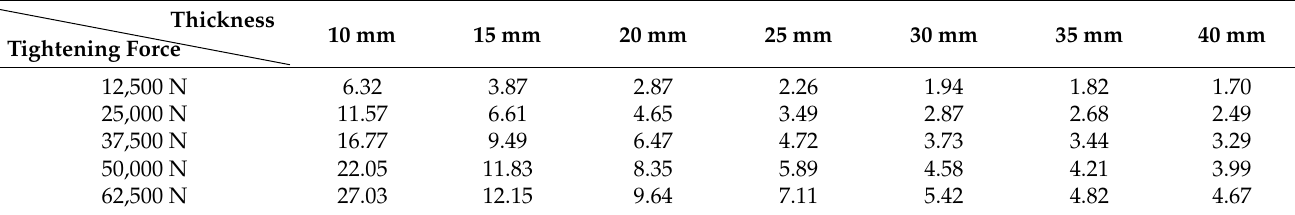
Table 3. The contact pressure under different connection conditions